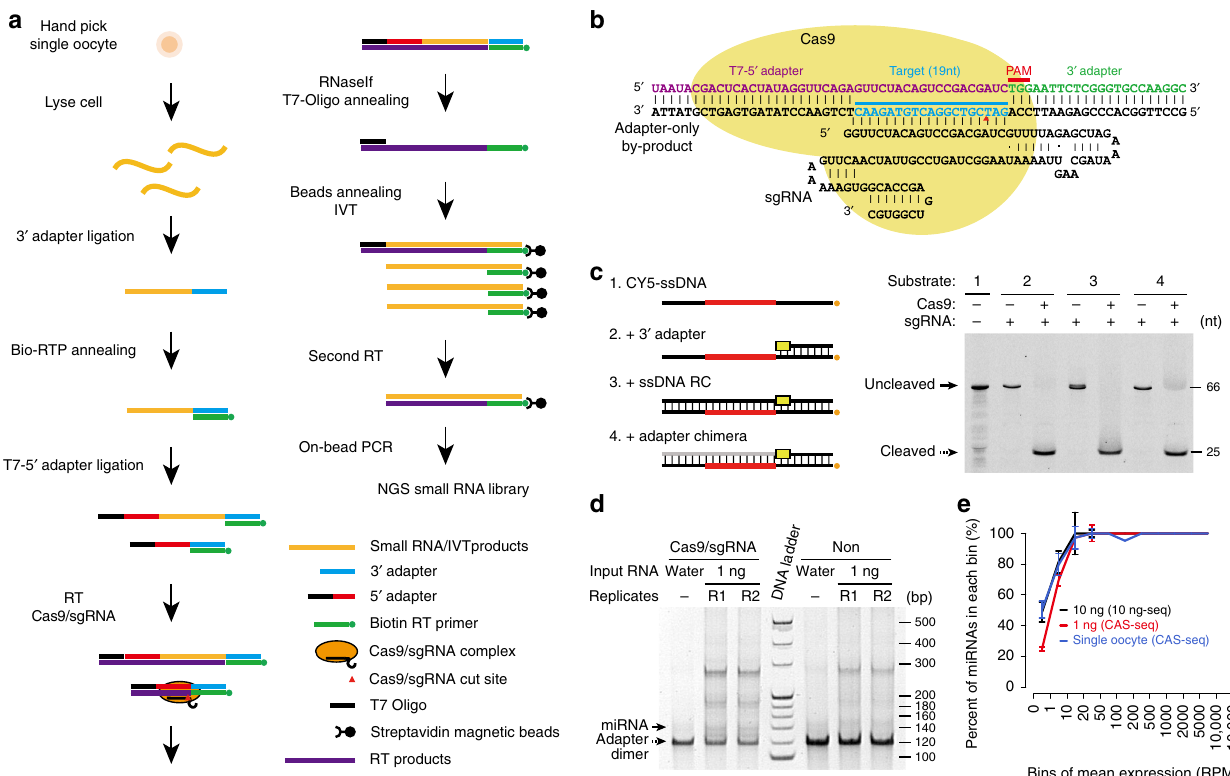
Fig. 1 Cas9-assisted sequencing of small RNAs. a An overview of the CAS-seq (Cas9-assisted small RNA-sequencing) method. RNA (yellow) from an individual oocyte was ligated sequentially with a 3 ′ adapter (blue) and a T7-5 ′ adapter (black and red). The ligation products were reverse-transcribed using a biotin-labelled reverse transcription (RT) primer (green), followed by Cas9/single guide RNA (sgRNA) cleavage to eliminate adapter heterodimers. The RT products were coupled to streptavidin beads for in vitro transcription (IVT) linear ampli fi cation. After a second round of reverse transcription, the beads were used directly for PCR ampli fi cation, and the library was size selected by polyacrylamide gel electrophoresis for next-generation sequencing. IVT, in vitro transcription. b Diagram of the Cas9-sgRNA designed to speci fi cally recognize and cleave the RT products of 5 ′ and 3 ′ adapter heterodimers. T7-5 ′ adapter (RNA oligo, purple); 3 ′ adapter (DNA oligo, green); DNA sequence targeted by sgRNA (DNA oligo, blue); PAM sequence (TGG at the 5 ′ end of the 3 ′ adapter). c Denatured polyacrylamide gel electrophoresis (PAGE) analysis of Cas9-sgRNA cleavage products. The substrates of Cas9/sgRNA are shown on the left. DNA oligo (black), PAM sequence (yellow box), sgRNA target region (red), RNA oligo (gray), and CY5 fl uorescence (orange). d Comparison of small RNA library construction results with or without Cas9/sgRNA treatment. One nanogram of human embryonic kidney 293 (HEK293) total RNA was used as the input, and the PCR ampli fi cation products were analyzed by 6% PAGE. e Sensitivity comparison of CAS-seq and other methods to detect microRNAs (miRNAs) in mouse oocytes. Total RNA (1 ng) from mouse oocytes (red) and a single mouse oocyte (blue) were sequenced by CAS- seq, and 10 ng of total RNA from mouse oocytes (black) was sequenced using our previously reported 10 ng sequencing protocol. The mean and standard deviation of the percentage of miRNAs detected by each method are shown. Source data of c – e are provided in the Source Data fi